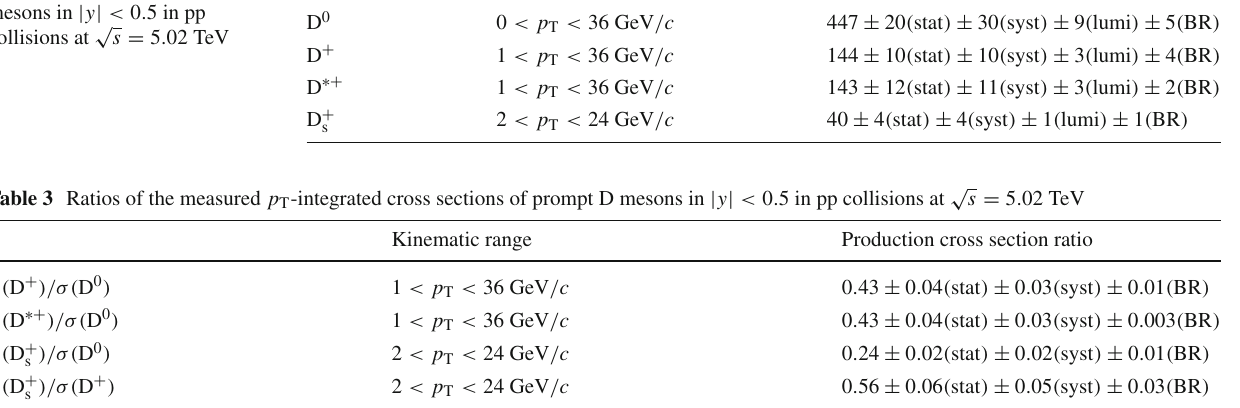
Kinematic range Visible cross section ( µ b)